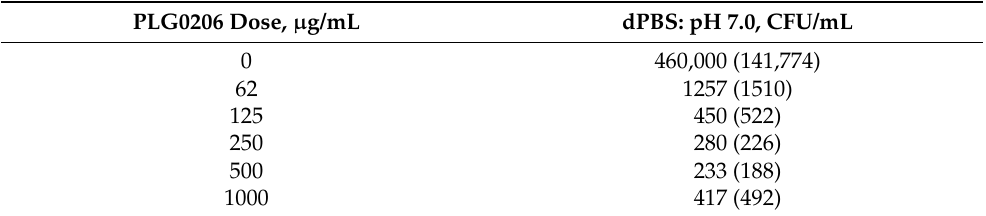
Table 2. Activity of PLG0206 in dPBS (pH 7.0) against S. aureus biofilms. Data from Mandell et al.,